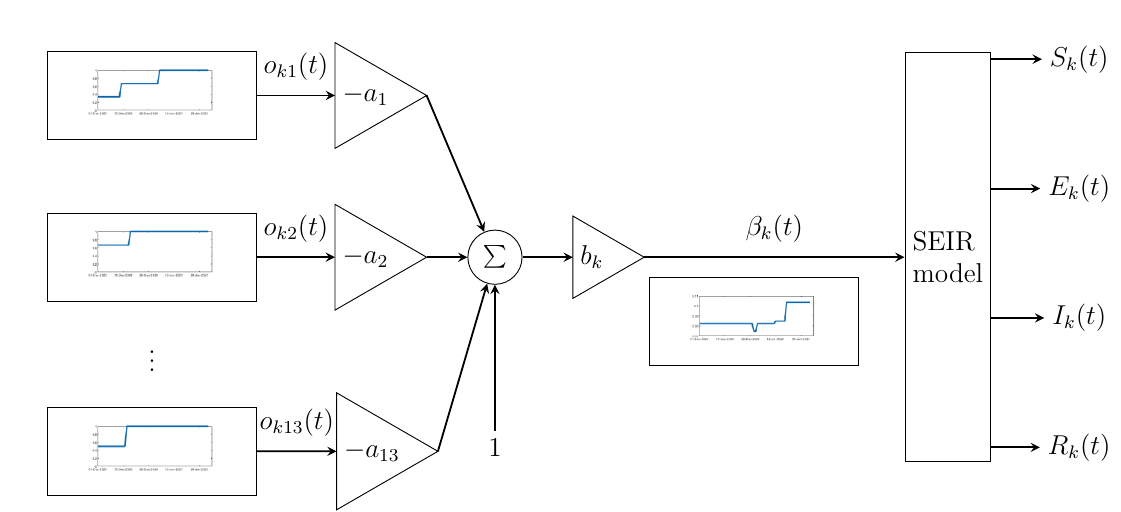
Table 2. Comparison of approaches to modeling a set of entities. Undesired characteristics are indicated in red.